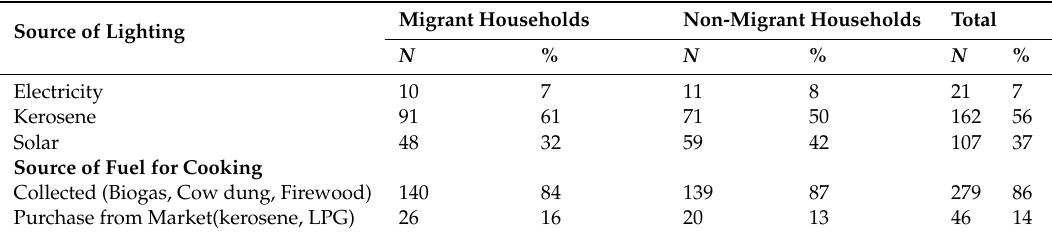
Table 15. Sources of